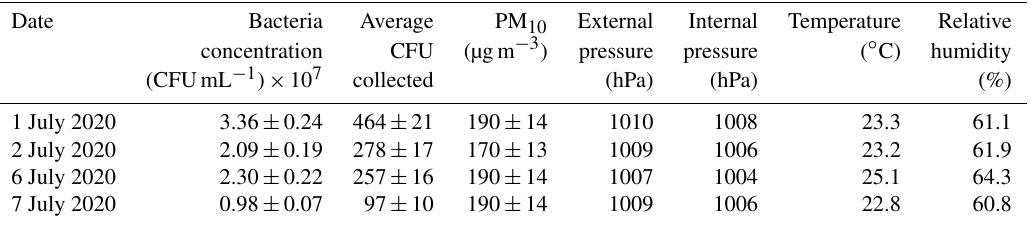
Table 2. Bacteria concentration in the aerosolized solution, average number of colonies counted on the petri dishes, and the meteorological parameters ( P , T , RH) in ChAMBRe in the experiments with the BLAM nebulizer operated at: liquid feed rate = 0.4mLmin − 1 , volume of